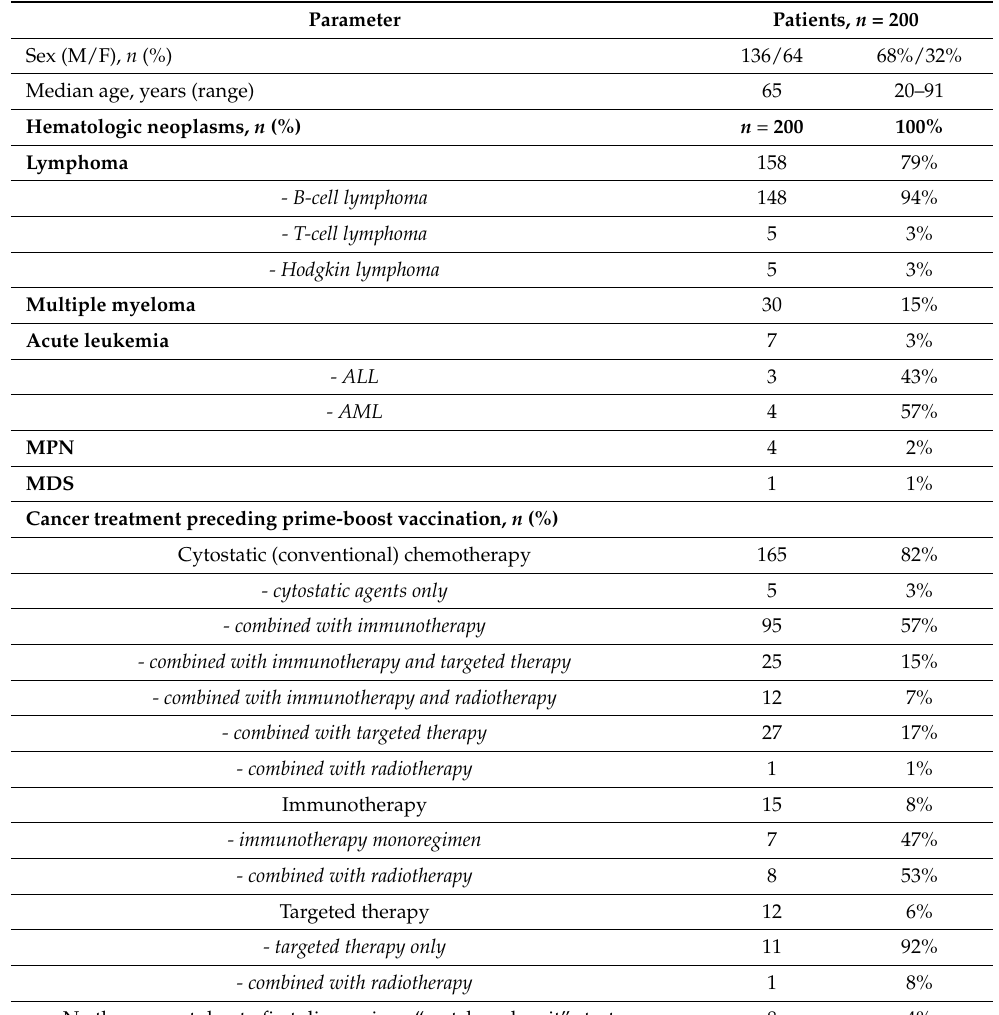
Table 1. Clinical characteristics and anti-cancer treatment of 200 patients with hematologic malignan- cies (HMs) at the time of COVID-19 prime-boost vaccination. Parameter Patients, n = 200 Sex (M/F), n (%)